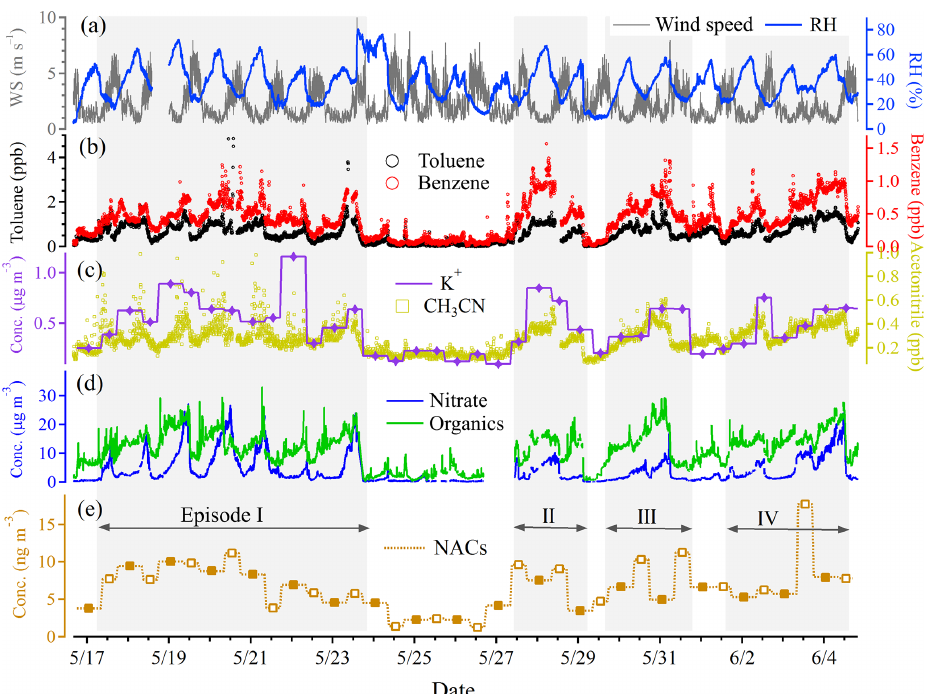
Figure 3. Time series of (a) wind speed (WS) and relative humidity (RH), (b) benzene and toluene, mass concentrations of (c) K + , (d) or- ganics and nitrate, and (e) NACs. The pollution episodes, with elevated organic aerosols, are marked by gray shading.